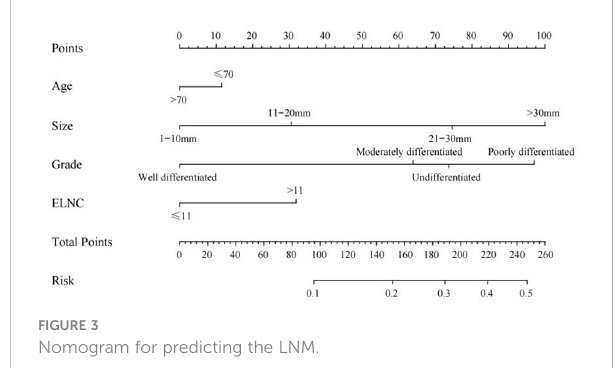
FIGURE 3 Nomogram for predicting the LNM.